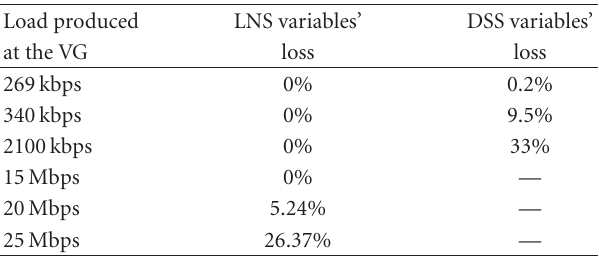
Table 3: Variables’ loss at the user stations versus di ff erent loads produced at the